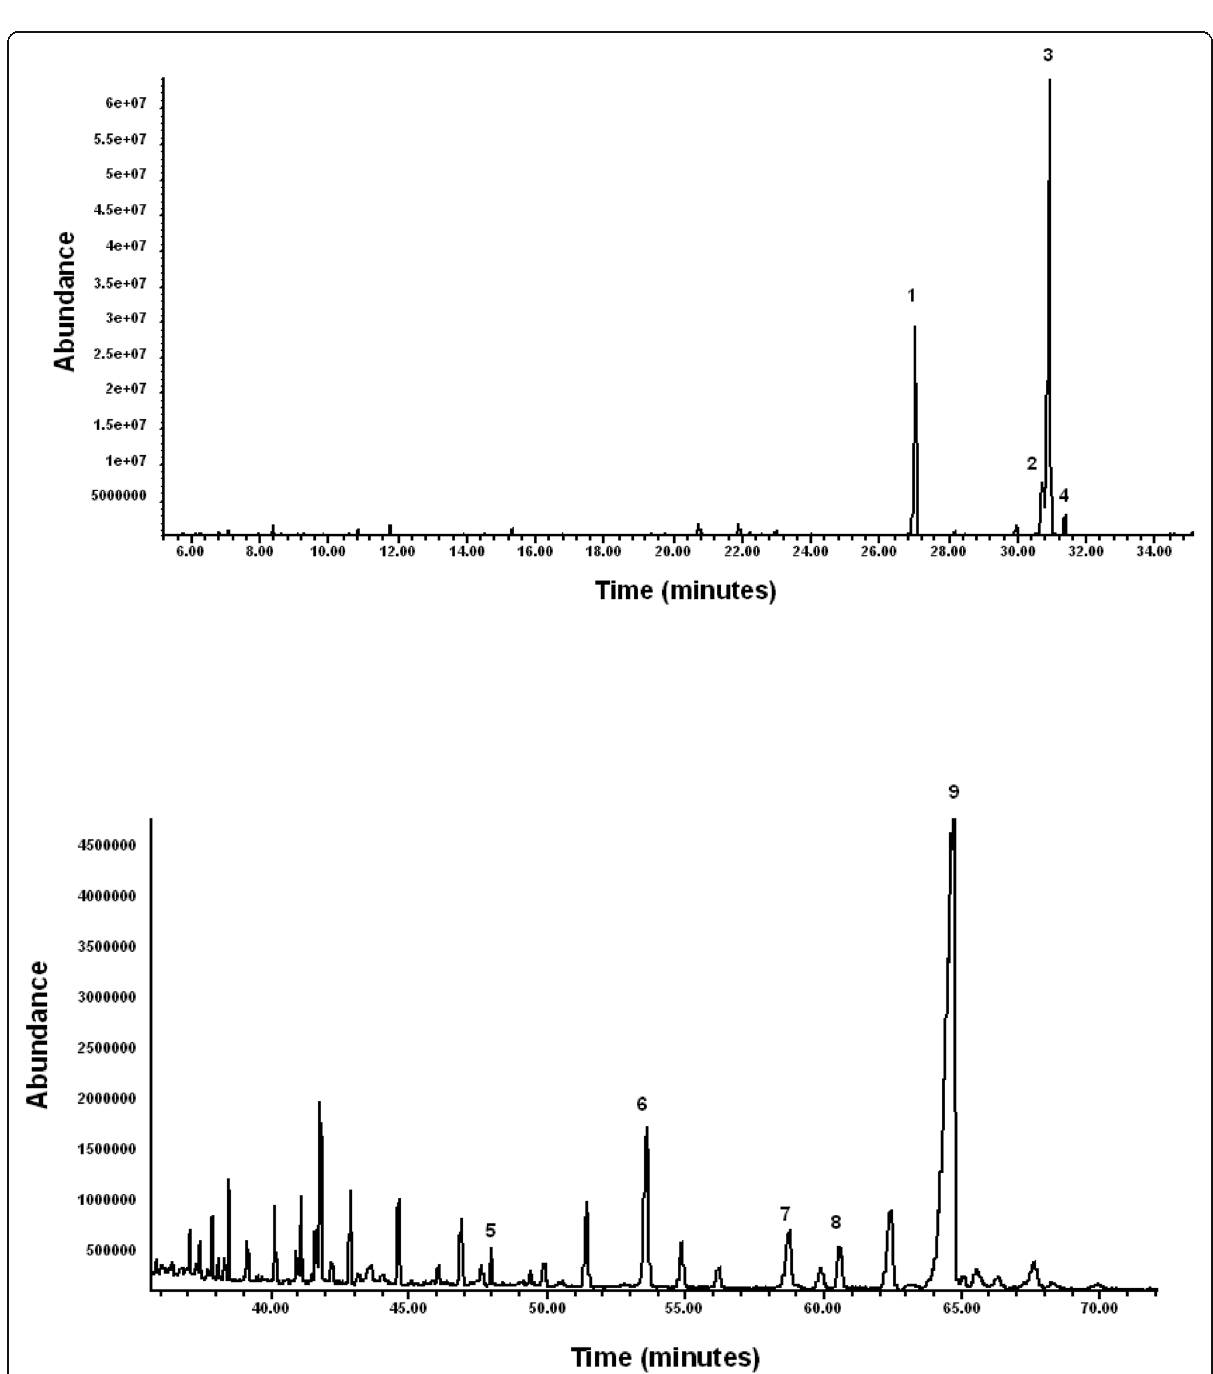
Fig. 3 Chromatogram (GC-EI-MS) of the hexane extract of Melissa officinalis following derivatization with